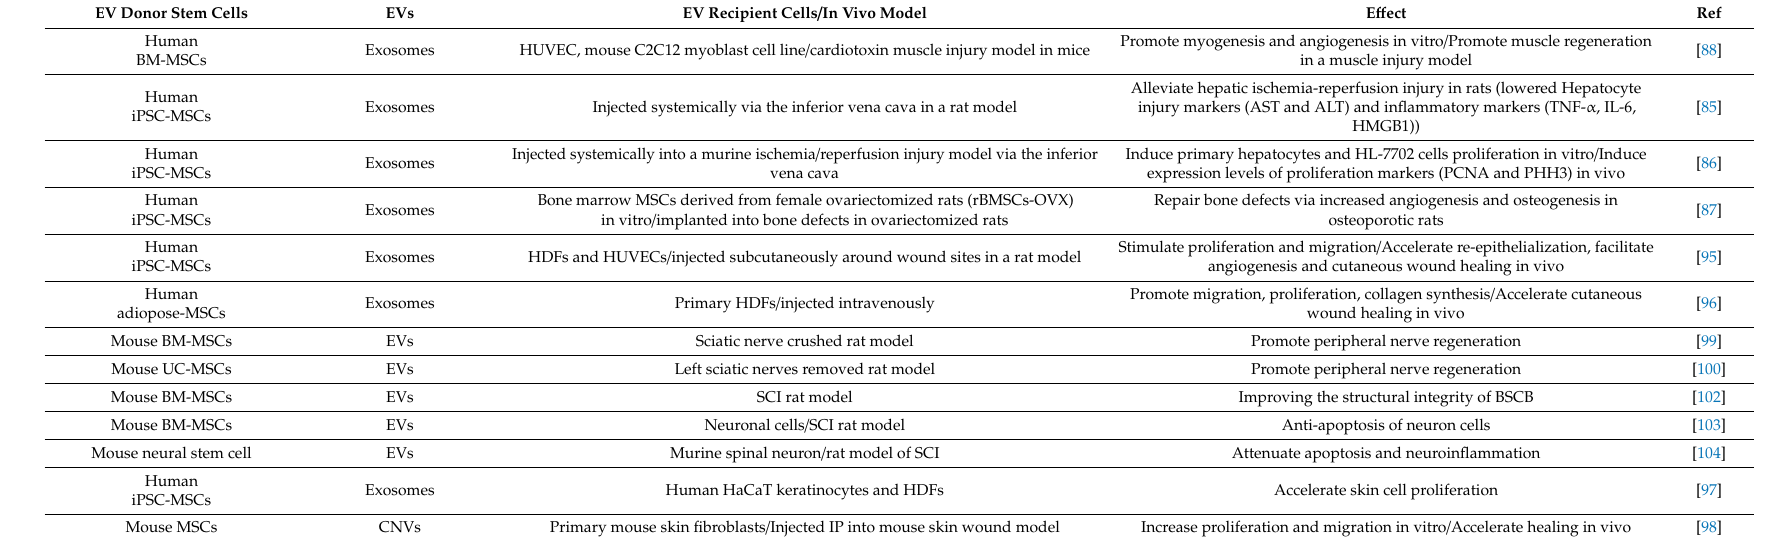
Table 2. E ff ect of multipotent stem cell-derived EVs according to recipient cells or in vivo